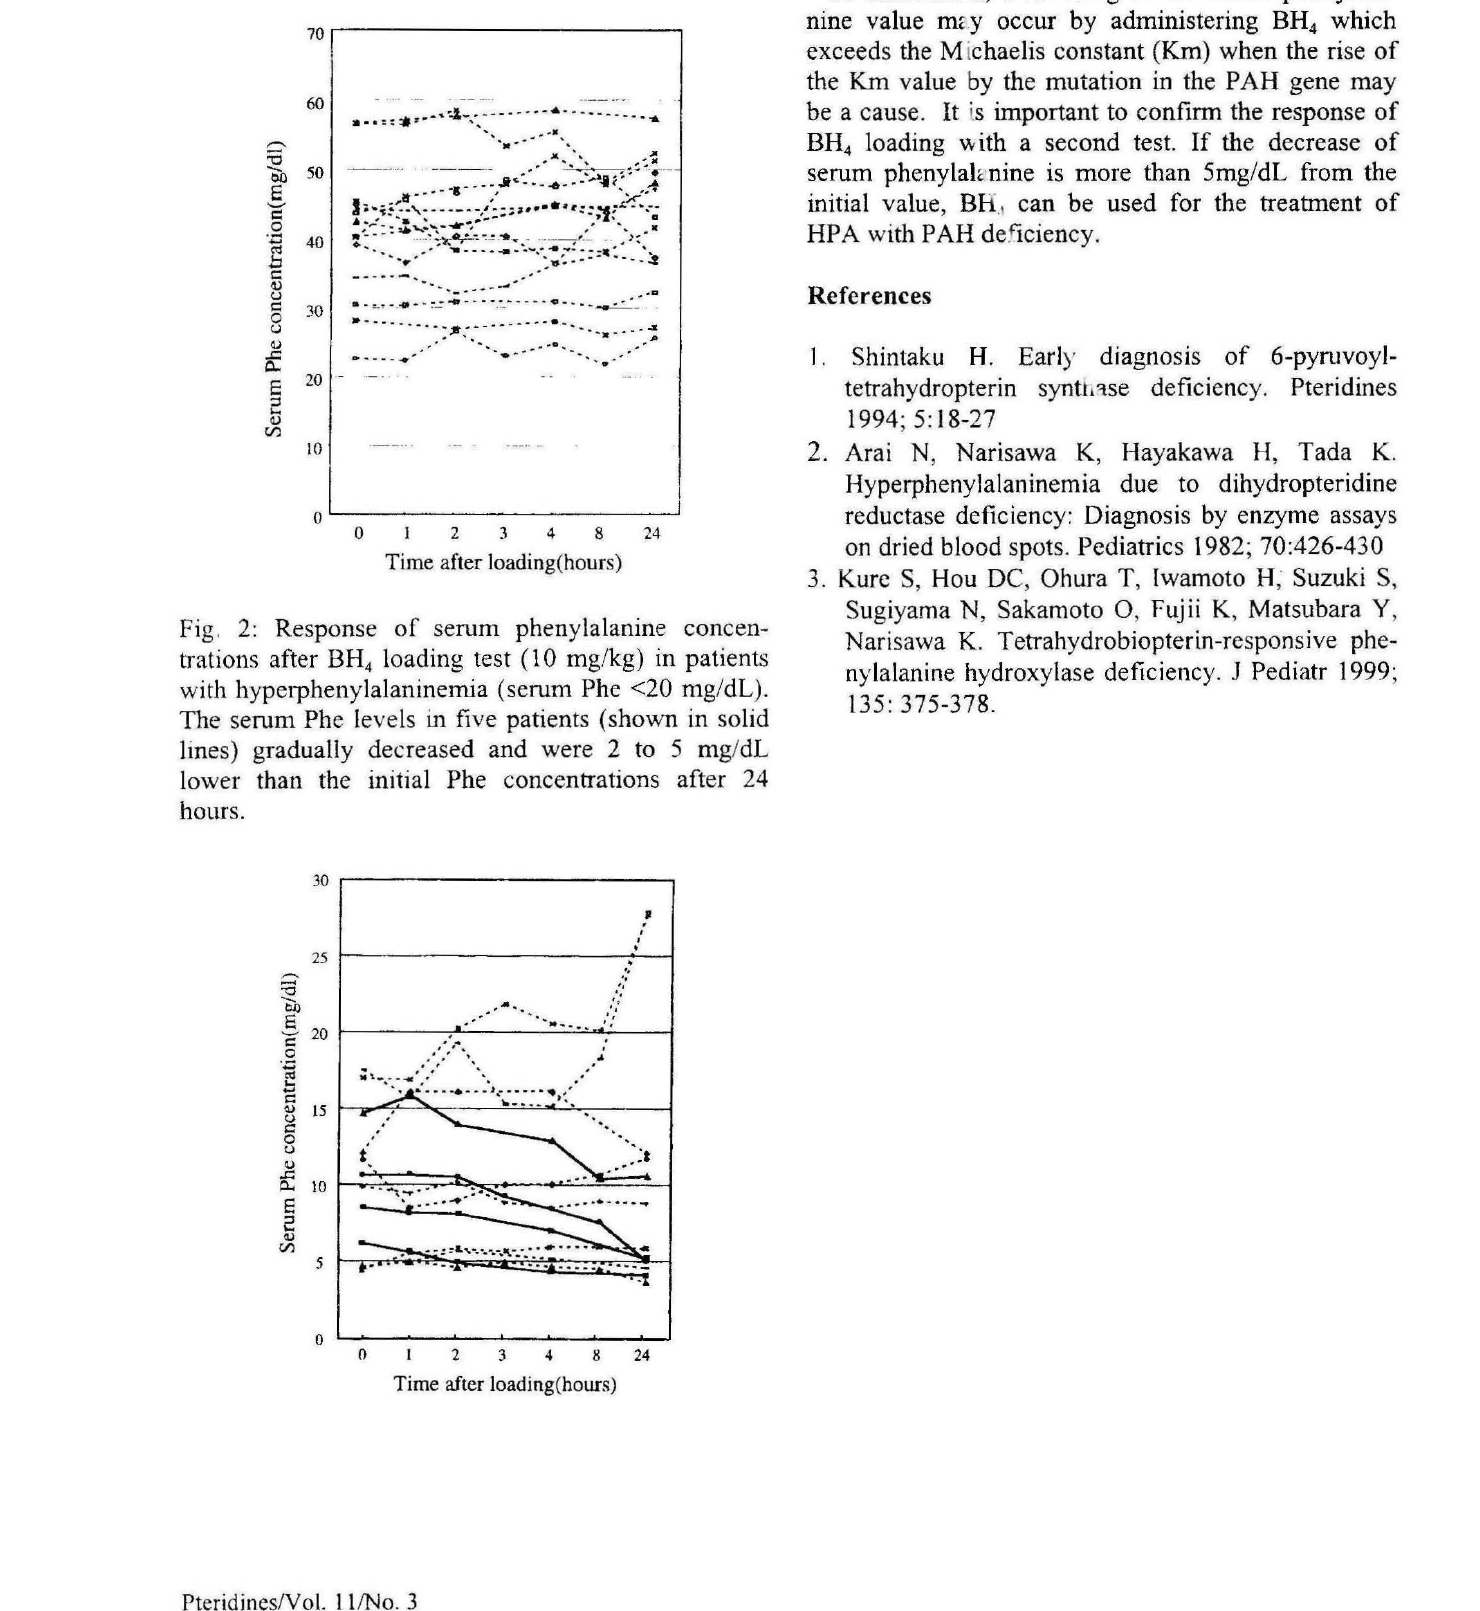
Fig.! : Response of serum phenylalanine concen trations after the BH4 loading test (10 mg/kg) in patients with PKU (>20 mg/dL).